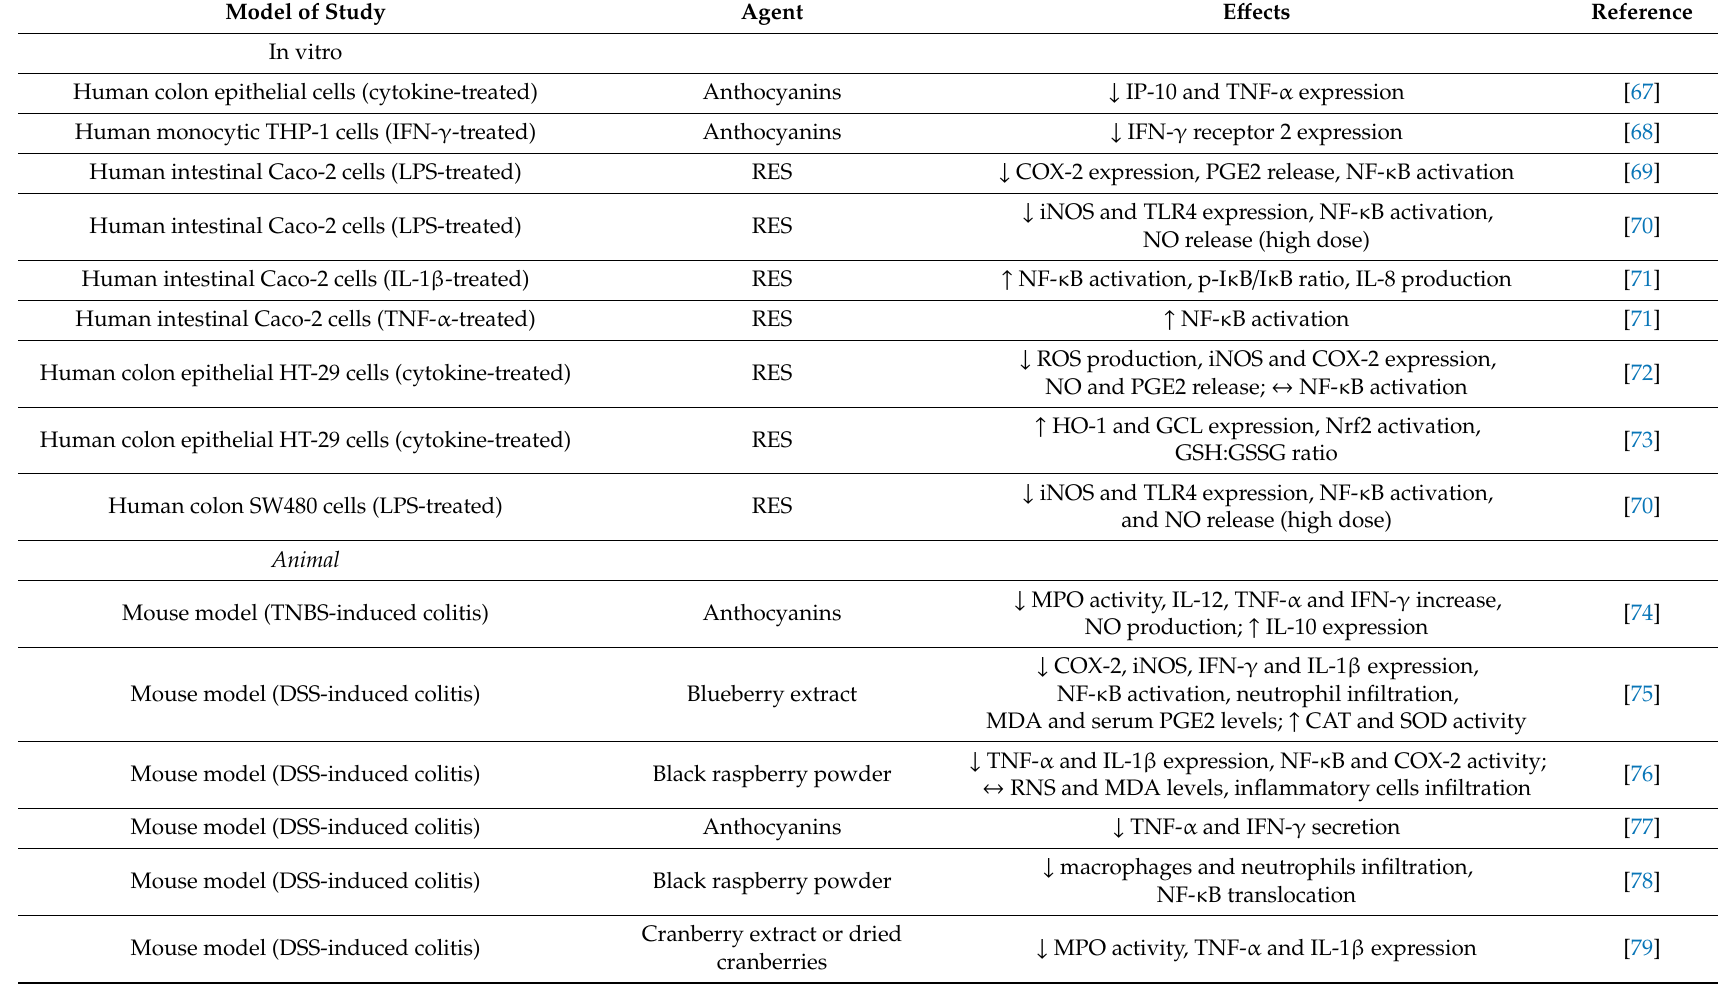
Table 3. Summary of the e ff ects of polyphenols on gut inflammation in the last 15 years